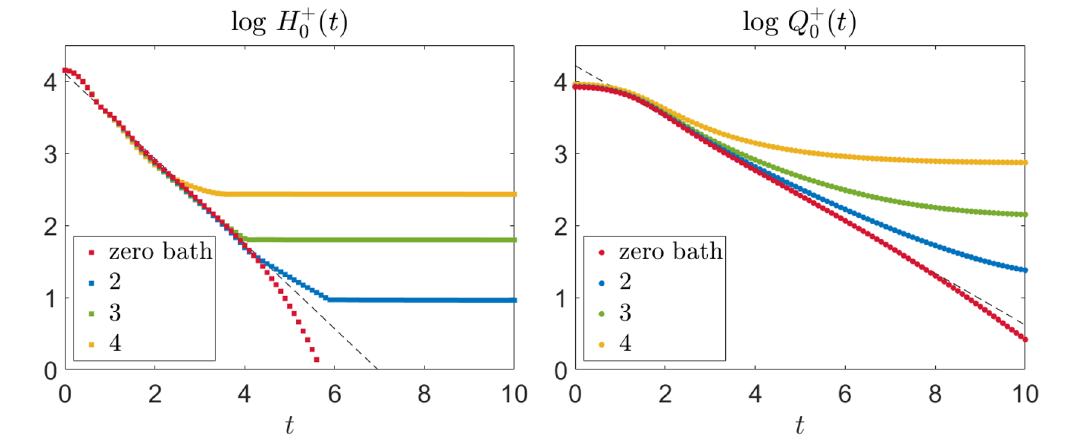
( t ) and log Q + ( t ) for log(2 T ) = 7 . 5 and σ = 12 and different Figure 5 . Left: the functions log H + m 0 0 bath temperatures T = 0 (no bath) and log(2 T ) = 2 , 3 , 4 . After an initial transient region, scaling is a a linear, with slopes that are different for each function and independent of the bath’s temperature. The presence of the bath determines only the value of time for which linear decay ends and saturation starts.